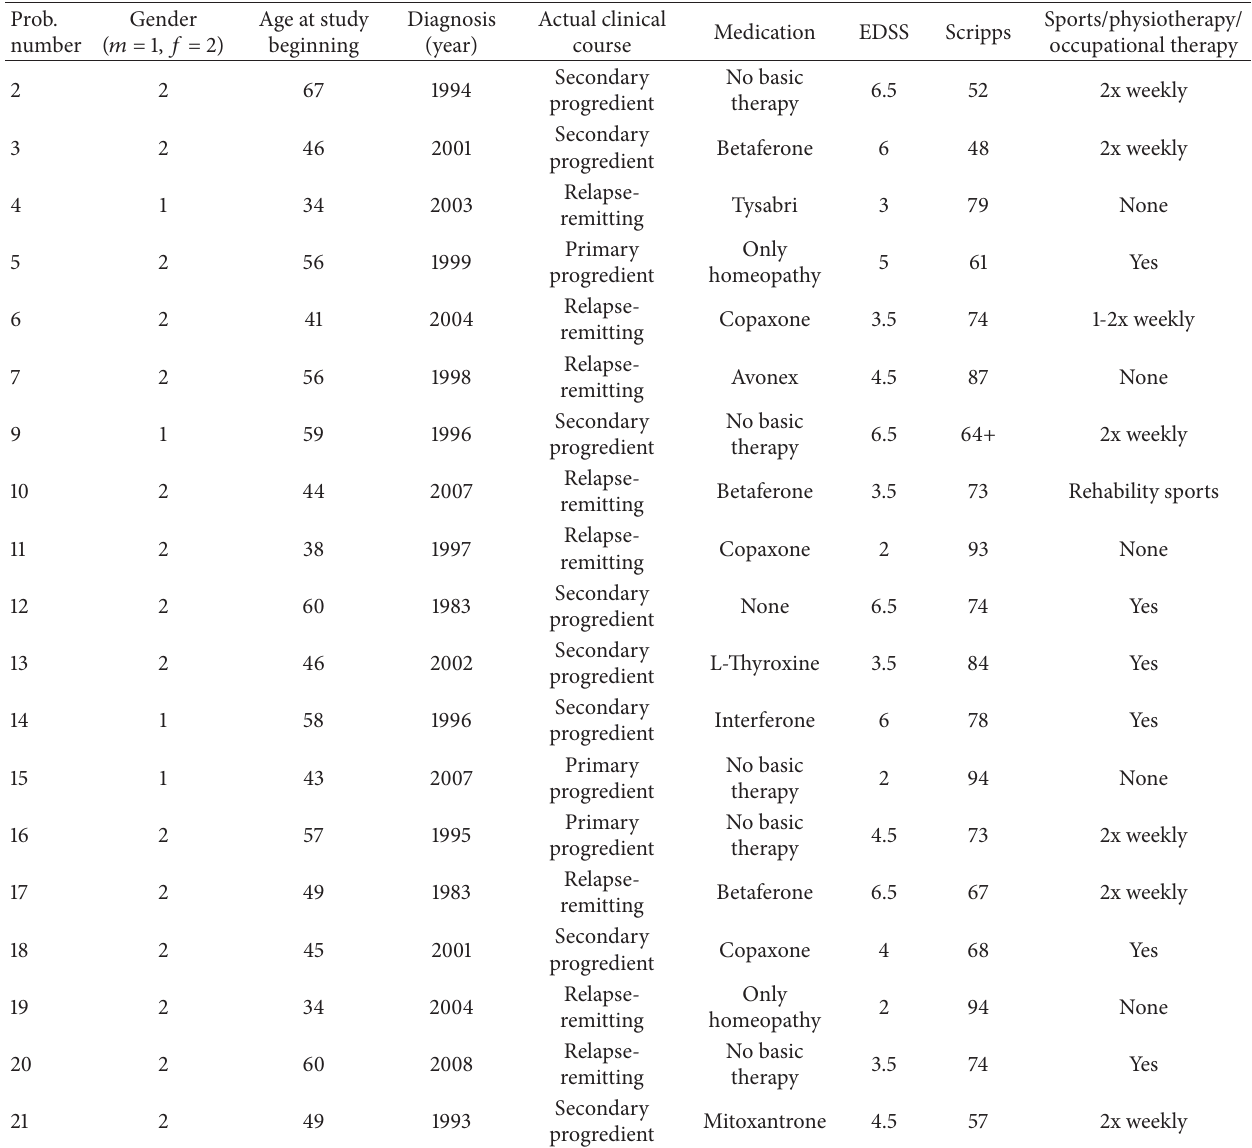
Table 1: Overview of data of the 19 participants at the beginning (April 2010).